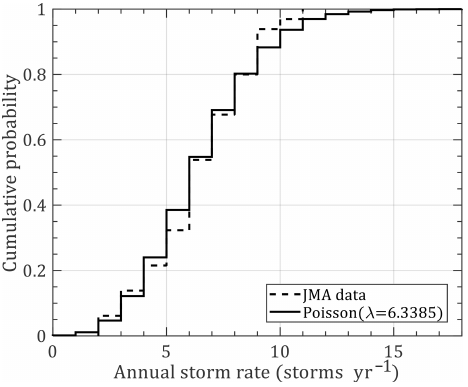
Figure 3. CDF of annual storm